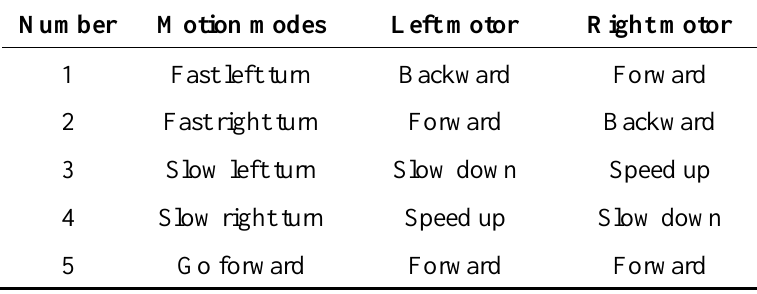
Table 3. Motion models of mobile